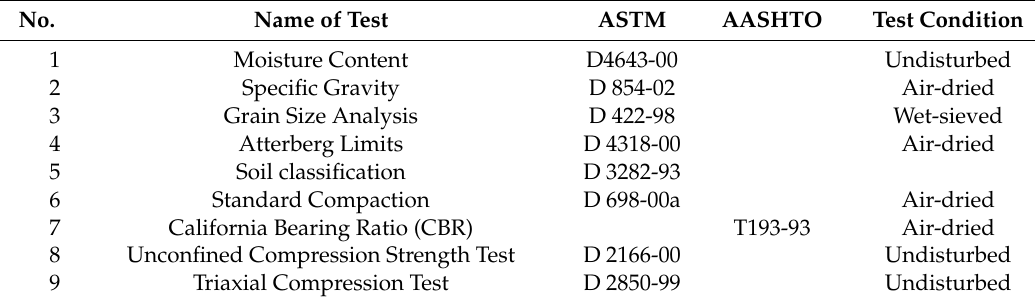
Table 1. Standard Testing